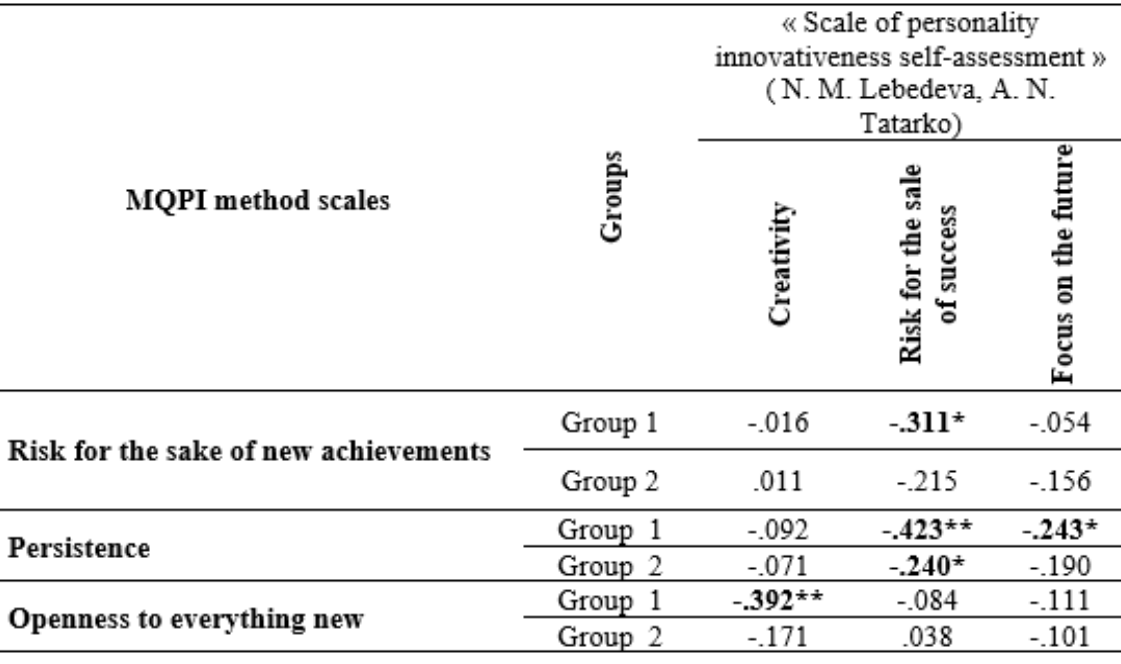
Table 3. The results of the correlation analysis by the MQPI methods and the Scale of personality innovativeness self-assessment (N. M. Lebedeva, A. N. Tatarko) in groups with dif - ferent levels of involvement (n=120)